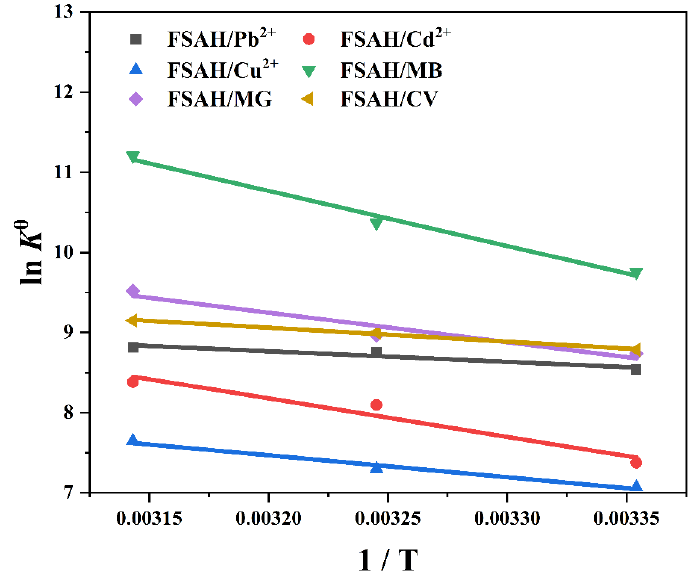
Figure 7. The adsorption capacity and the adsorption thermodynamics curve of heavy metal ions and dyes adsorption of FSAH at 298.15, 308.15, and 318.15 K, respectively.